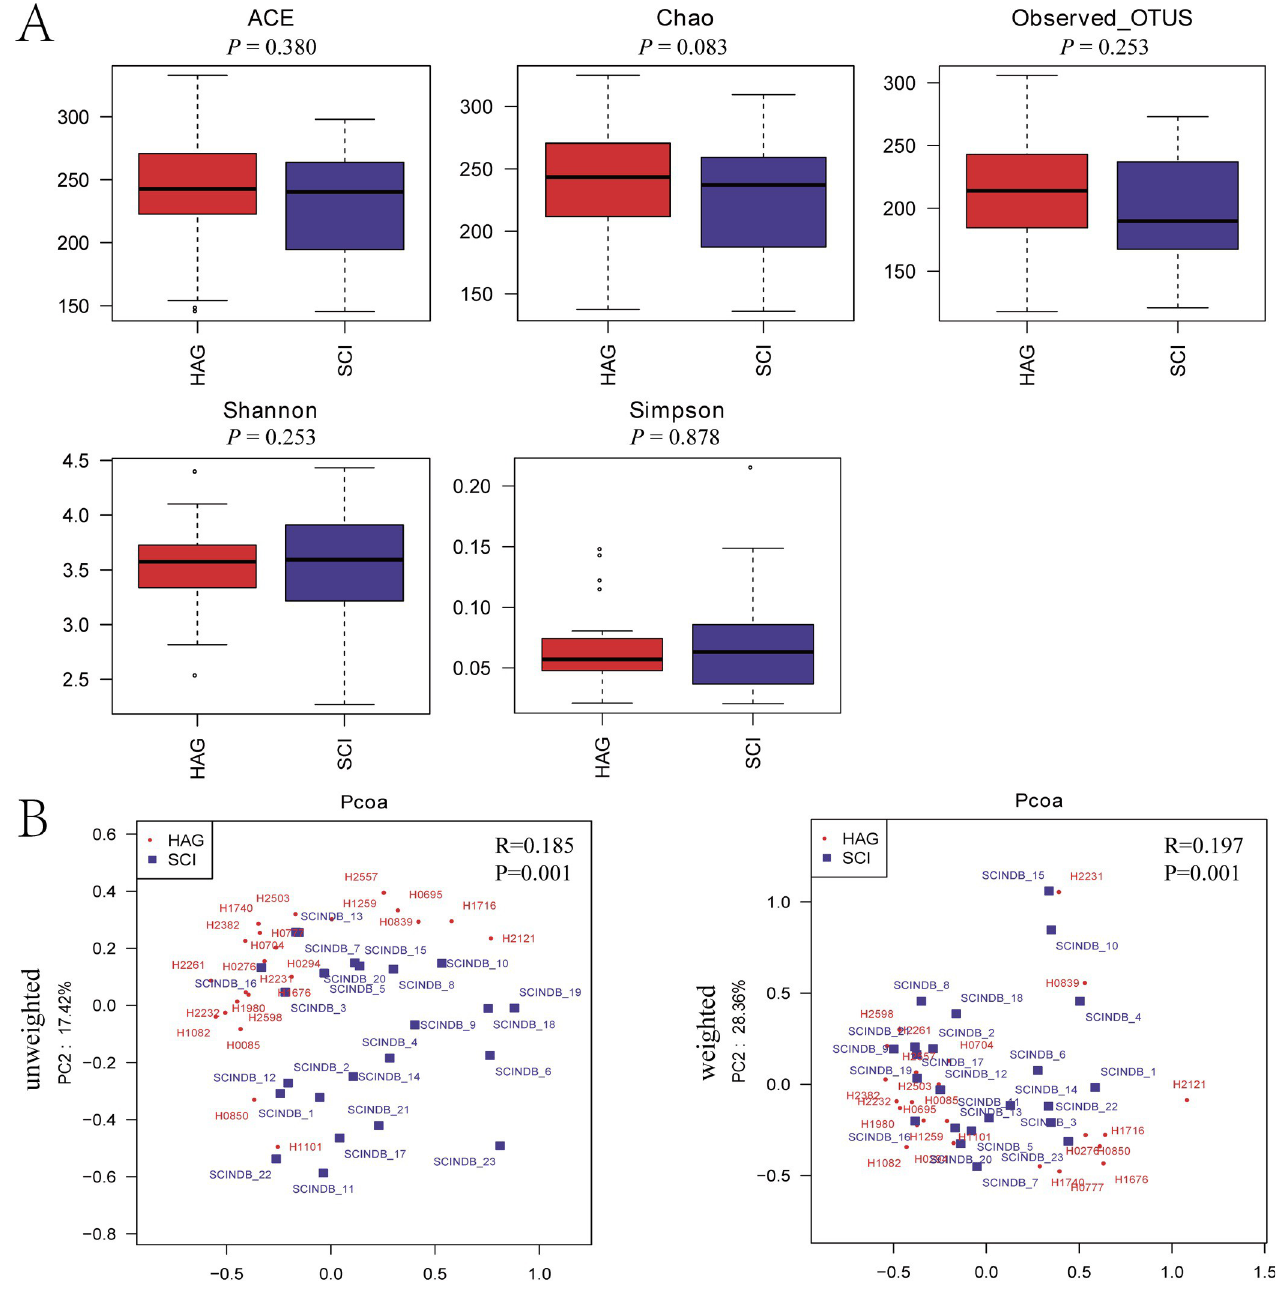
Fig 1. The α -diversity and β -diversity indices of the fecal microbiome in the SCI and healthy groups. (A) Box plots showing differences in the fecal microbiome diversity indices between the SCI and healthy groups according to the ACE, Chao, Observed_OTUs, Shannon, and Simpson diversity indices based on OTU levels. Each box plot represents the median, interquartile range, minimum, and maximum values. (B) Unweighted and weighted ANOSIMs and PCoA based on the UniFrac distance matrix of fecal microbial communities in the SCI and healthy groups. Respective ANOSIM R values show the community differences between the compared groups. The axes represent the two dimensions explaining the greatest ratio of variance in the communities. Each symbol represents a sample. SCI, spinal cord injury group (blue); HAG, healthy group (red); OTU, operational taxonomic unit; ANOSIM, analyses of similarities; PCoA, principal coordinates